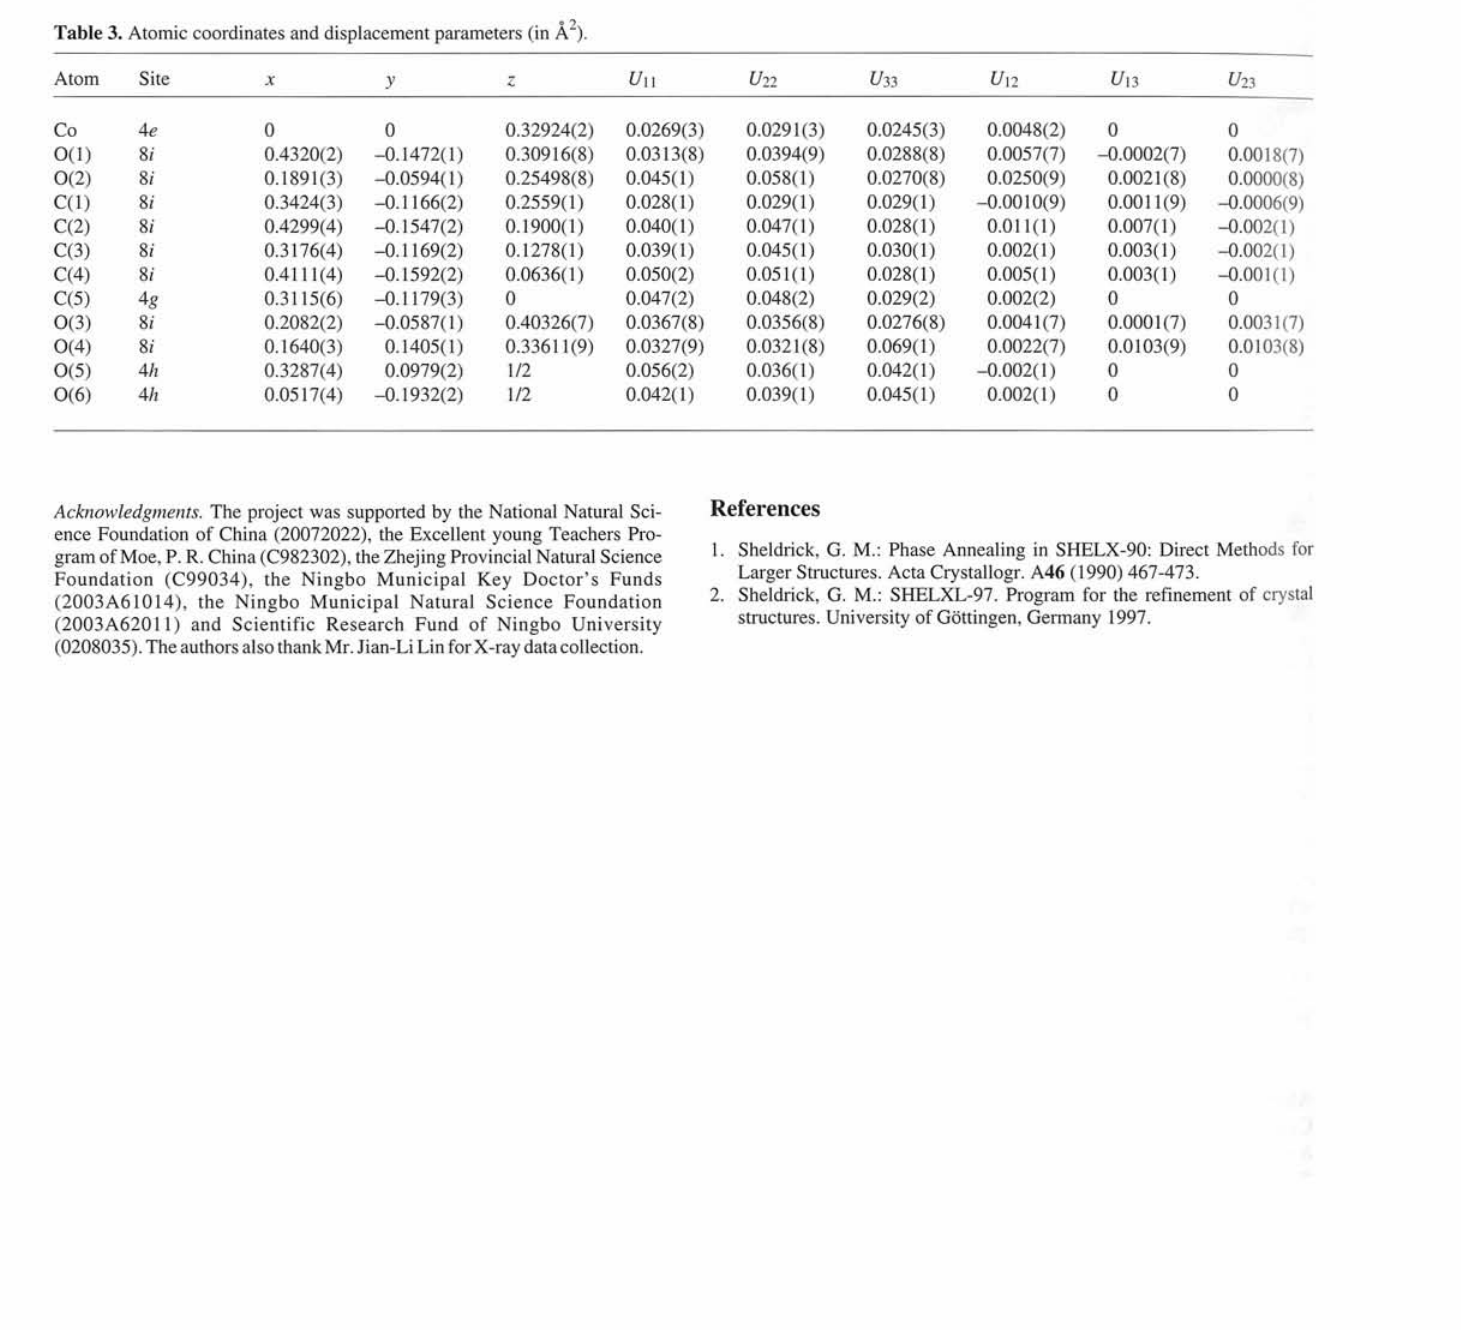
• Table 3. Atomic coordinates and displacement parameters (in